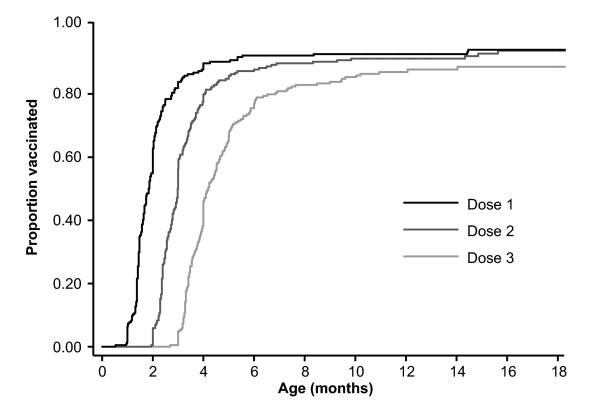
Pentavalent vaccine uptake among 204 in the simple random survey in Kilifi District, Kenya, by inverse Kaplan-Meier survival function